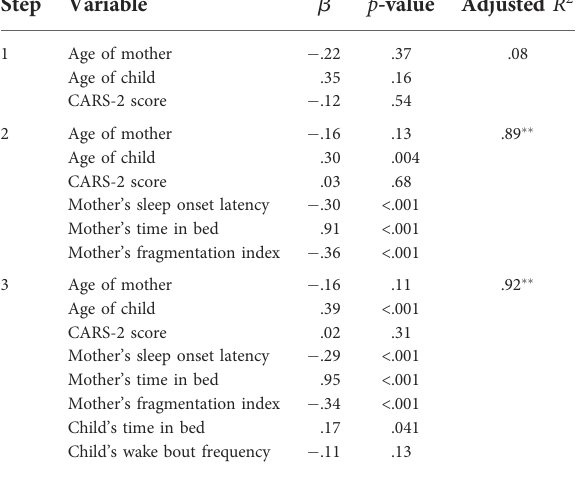
TABLE 8 Hierarchical multiple regression predicting Actual Sleep Time in mothers.